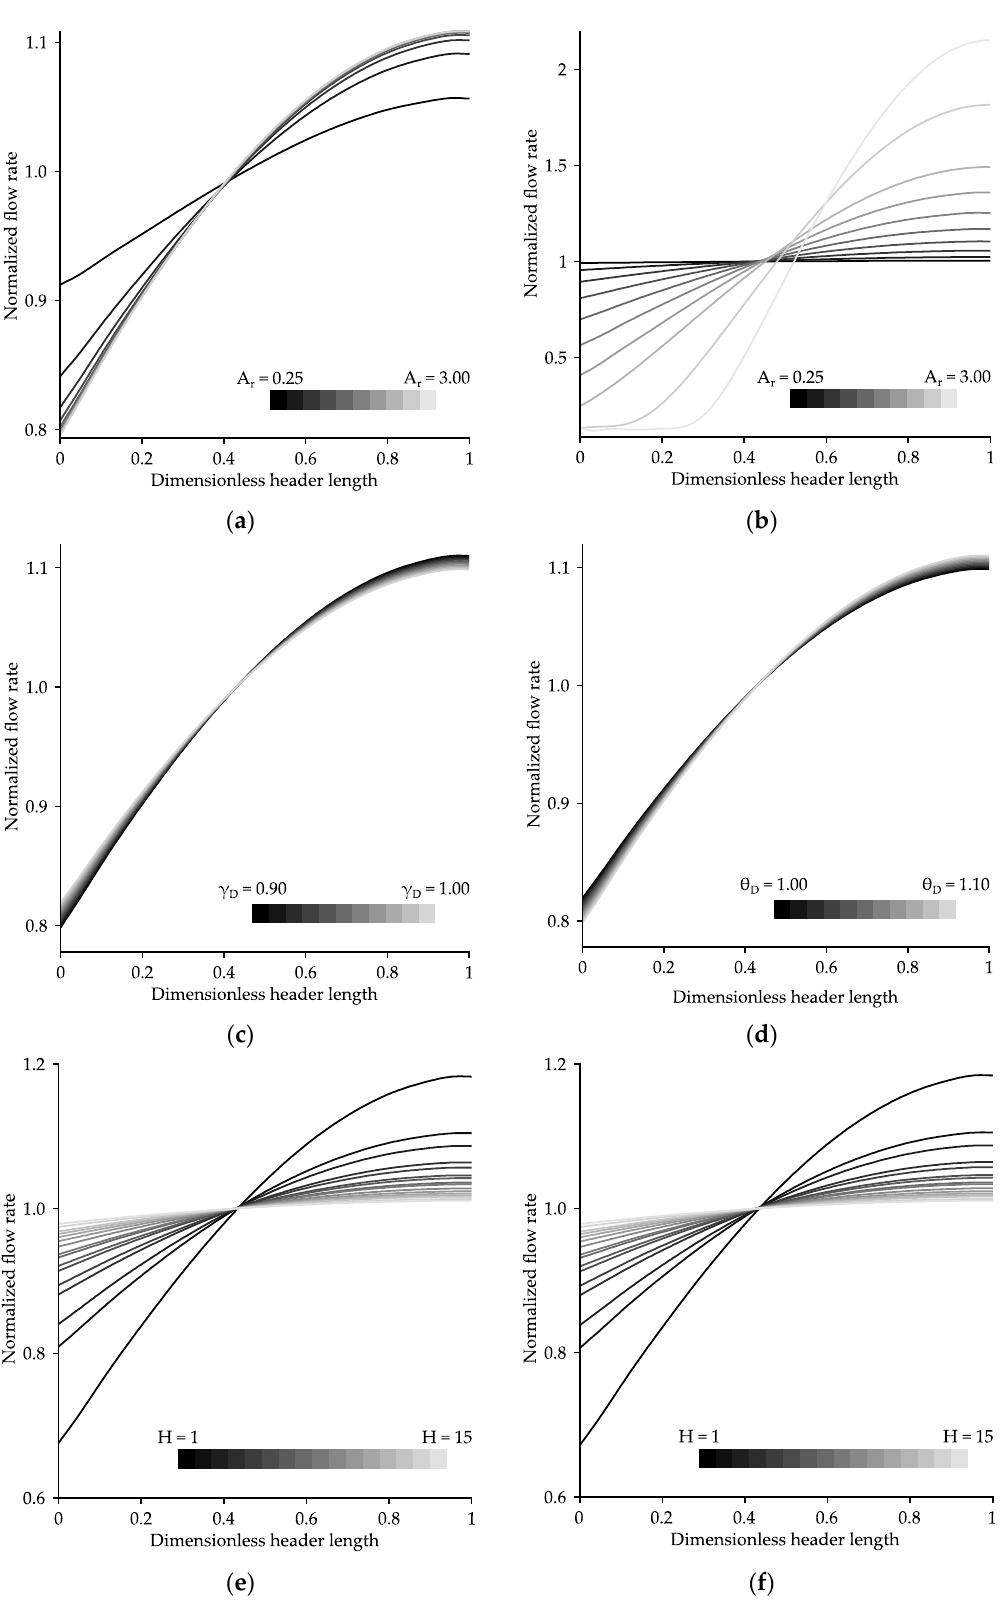
Figure 5. Results of the sensitivity study: ( a ) dependence of Model B on A r ; ( b ) dependence of Model BJ on A r ; ( c ) dependence of Model B on γ D ; ( d ) dependence of Model BJ on θ D ; ( e ) dependence of Model B on H; ( f ) dependence of Model BJ on H.